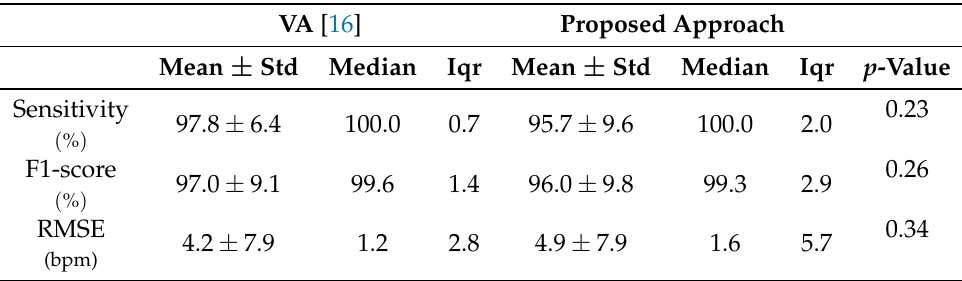
Table 2. Mean ± standard deviation, median value, interquartile range (iqr) of the proposed metrics evaluated on DS-PN (Physionet Database) with VA and the proposed methods. To compare the methods, the p -value is reported. DS-PN dataset contains 75 subjects.